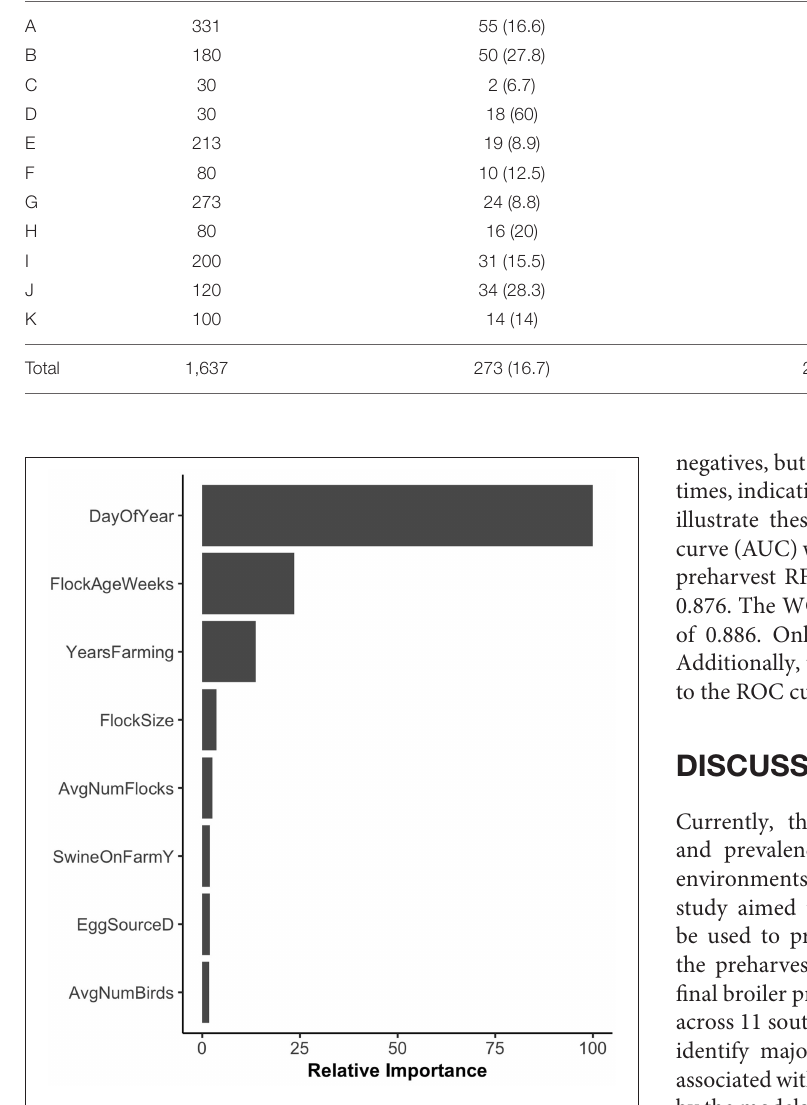
FIGURE 1 | Variable importance plot for the preharvest sample random forest model. Relative importance is determined by average mean decrease in Gini and scaled from 0 to 100, where 100 is most important. SwineOnFarmY refers to farms that had swine present at the farm. EggSourceD refers to farms that received broiler eggs from Company